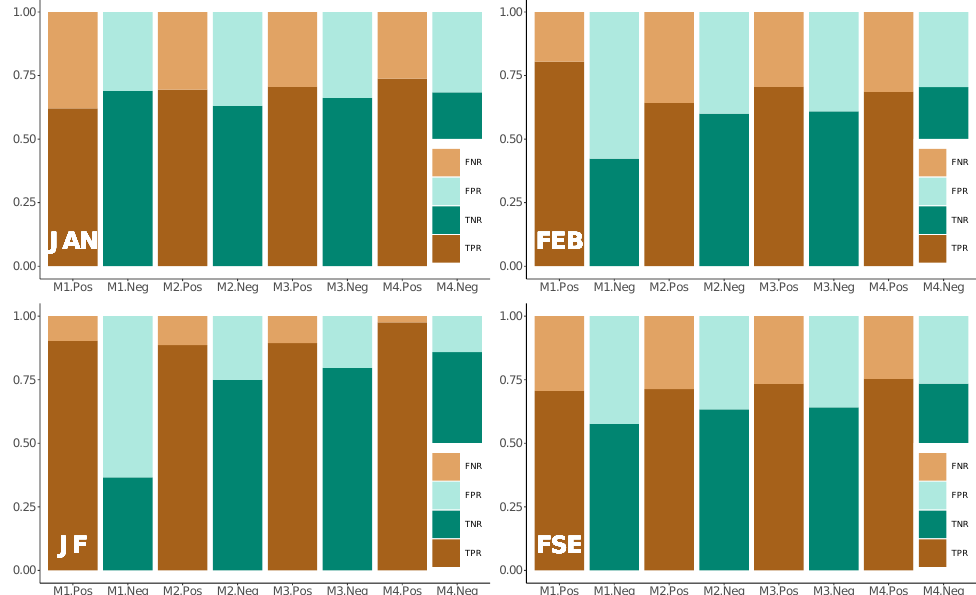
Figure 14. TPR, TNR, FPR and FNR values calculated for the entire landslide susceptibility maps of the datasets JAN, FEB, JF and FSE.